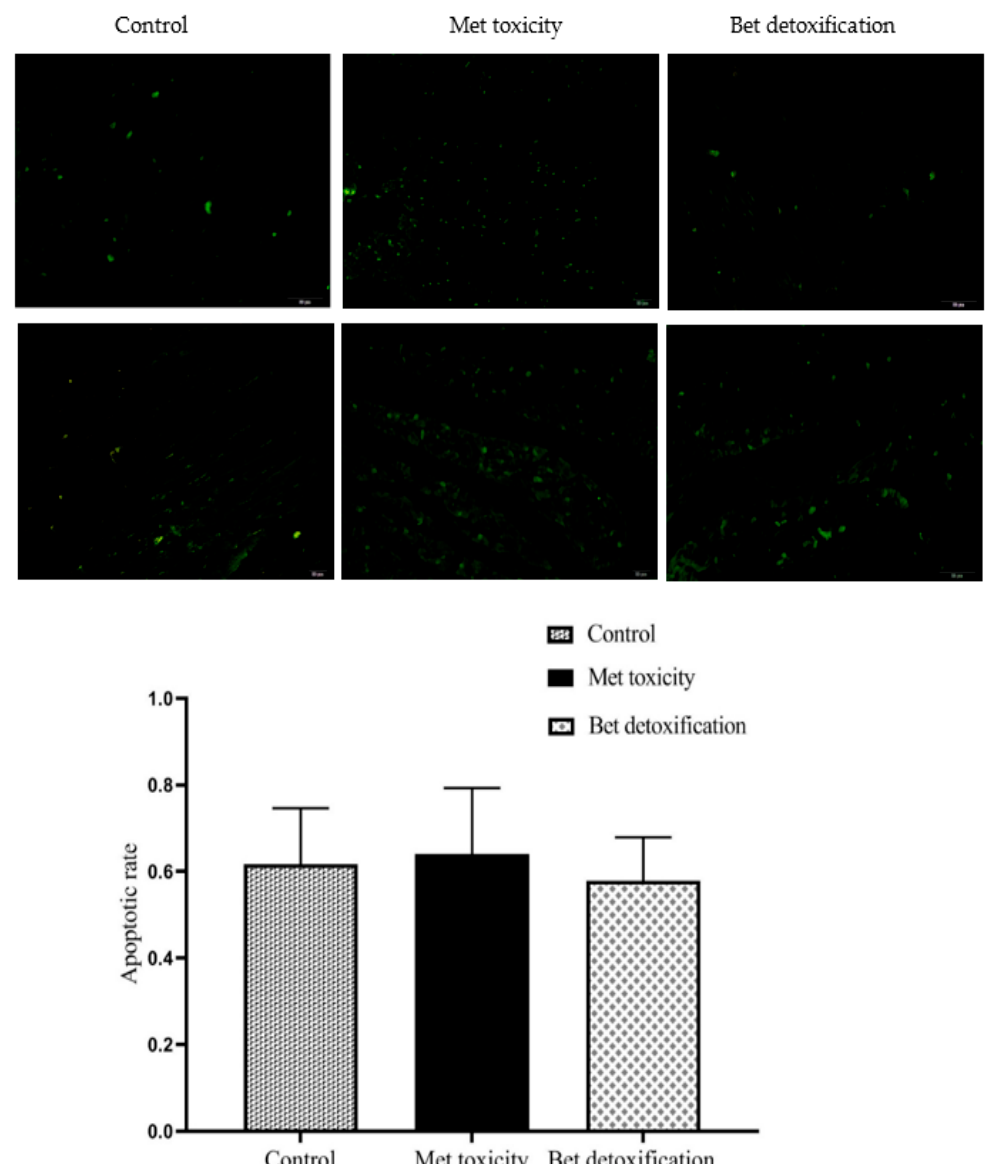
Figure 1. Effect of betaine on cardiomyocyte apoptosis in geese with hyperhomocysteinemia. The control group received the basal diet from 14 to 70 d of age. The methionine (Met) toxicity group received the basal diet supplemented with 1% Met. The betaine (Bet) detoxification group received the Met toxicity diet supplemented with 0.2% Bet.